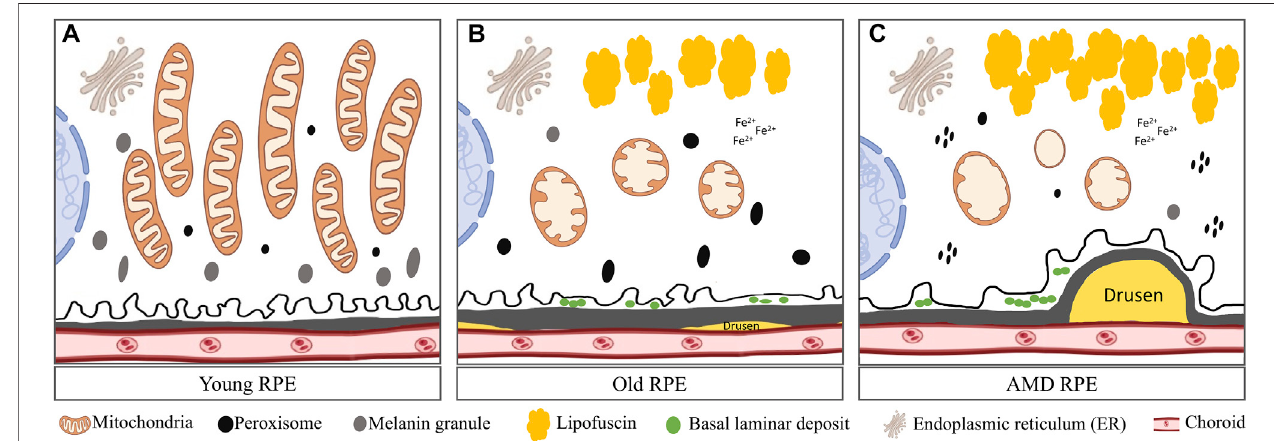
FIGURE2| Comparisonofmitochondriainyoung,agedandAMDRPE: (A) YoungRPEcellcontainsnumerousmitochondriawithlongaxes,usuallyorientedfrom the apical to the basal surfaces ofthe RPEand are parallel toone another. The mitochondrial cristae are well preserved. Several peroxisomes appeared as small, round, electron-dense organelles. Plenty of melanin granules exist in the cells. (B) In aged RPE cell, mitochondria show membrane disorganization and loss of cristae. Accumulated lipofuscin presents in the cell. Several peroxisomes of various density, shape and size were distributed randomly in the cytoplasm. Less melanin granules appear in the cell. Also, small drusen forms underneath BrM and basal lamina deposits forms in between the cell and BrM. (C) In AMD RPE, advanced mitochondrial alterations occur. Most mitochondria had severe disorganization of membranes that varied from focal to complete loss of cristae. Peroxisomes are clustered and aggregated in the cell. Large and soft drusen forms underneath the